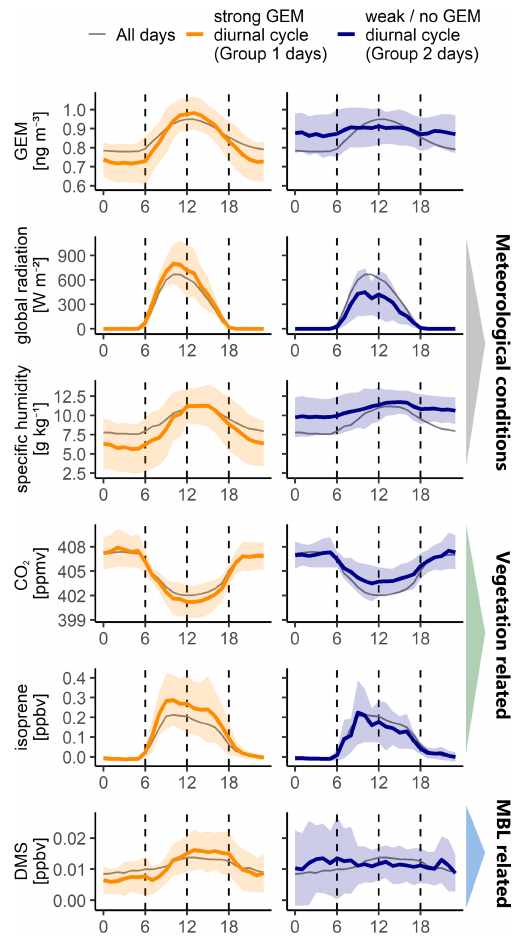
Figure 5. Mean diurnal variation (arithmetic average) of GEM, solar radiation, specific humidity, CO 2 , isoprene, and DMS. Days have been grouped into two main groups as a function of the am- plitude of diurnal GEM variation (the difference between nighttime and noon). The left column corresponds to all data on days with an especially marked GEM diurnal variation (Group 1), and the right column corresponds to all data on days with no or only a weak diur- nal GEM variation (Group 2). The thin gray line shows the average diurnal cycle for all days (for which GEM observations are also available). The shaded area corresponds to the mean ± 1 standard